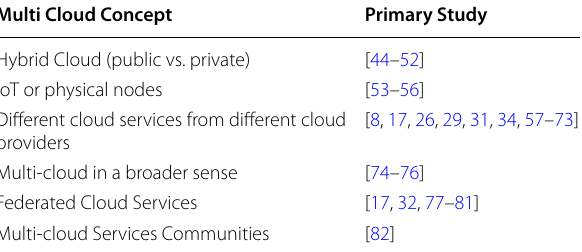
Table 6 Studies classification per multi‑cloud definition Multi Cloud Concept Primary